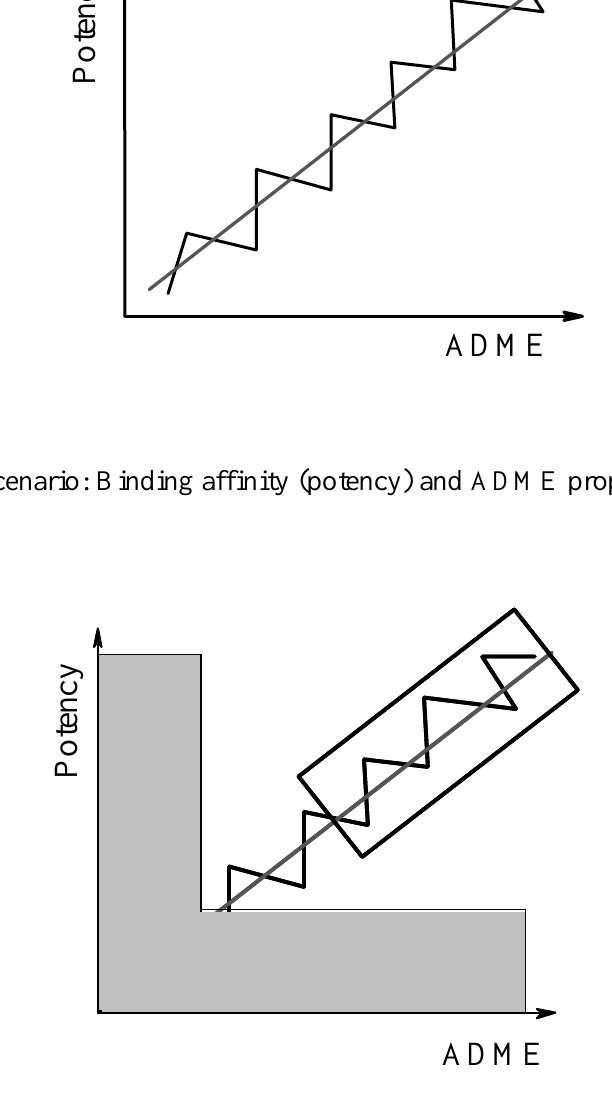
Figure 4. Zooming in on compounds of interest: Molecules located in the shaded area are eliminated in the early stages of virtual screening, using various (pre)filtering schemes. Molecules located in the boxed area are then investigated with more accurate methods in a second